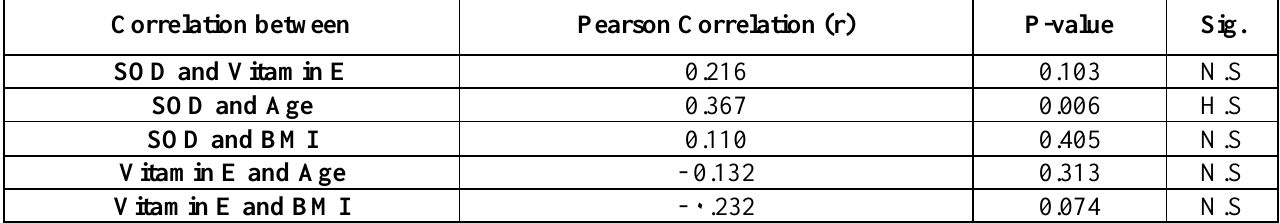
Table 6: Correlations between parameters in leukemia